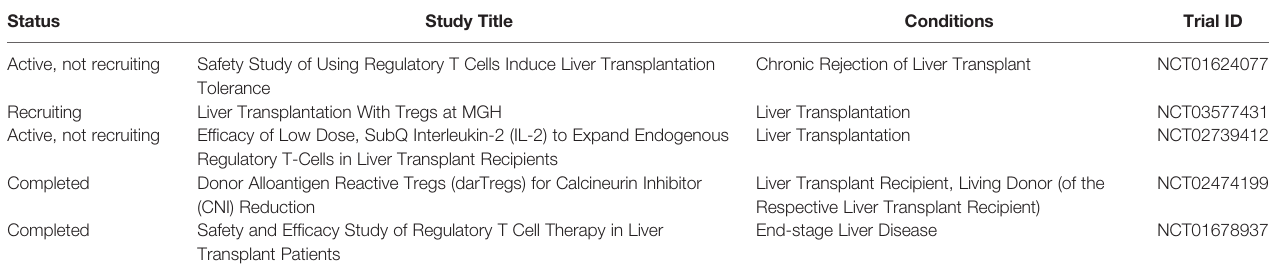
TABLE 1 | The clinical trial for tregs in liver